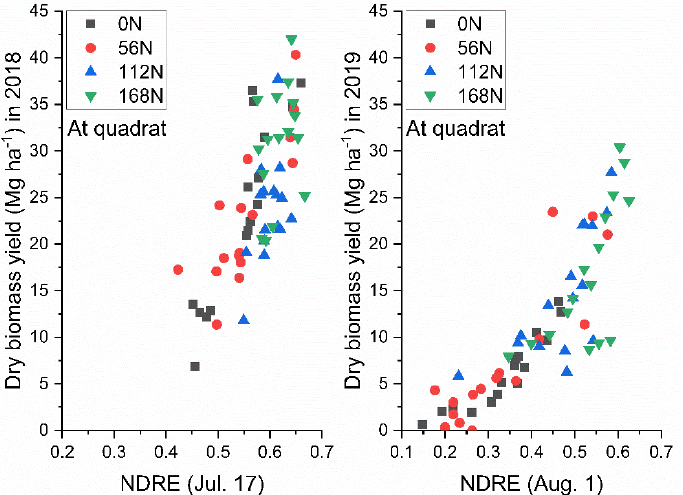
Figure 7. Nitrogen response was observed in the relationship between NDRE and dry biomass during the mid-summer growing season in 2018 and 2019. Biomass yield and plant stand health improved with increasing N fertilization.